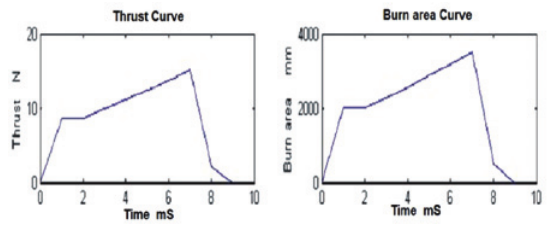
Fig. 12. Star grain thrust and burn area time curves Comparison of thrust time and burn area time out- put indicates the following.